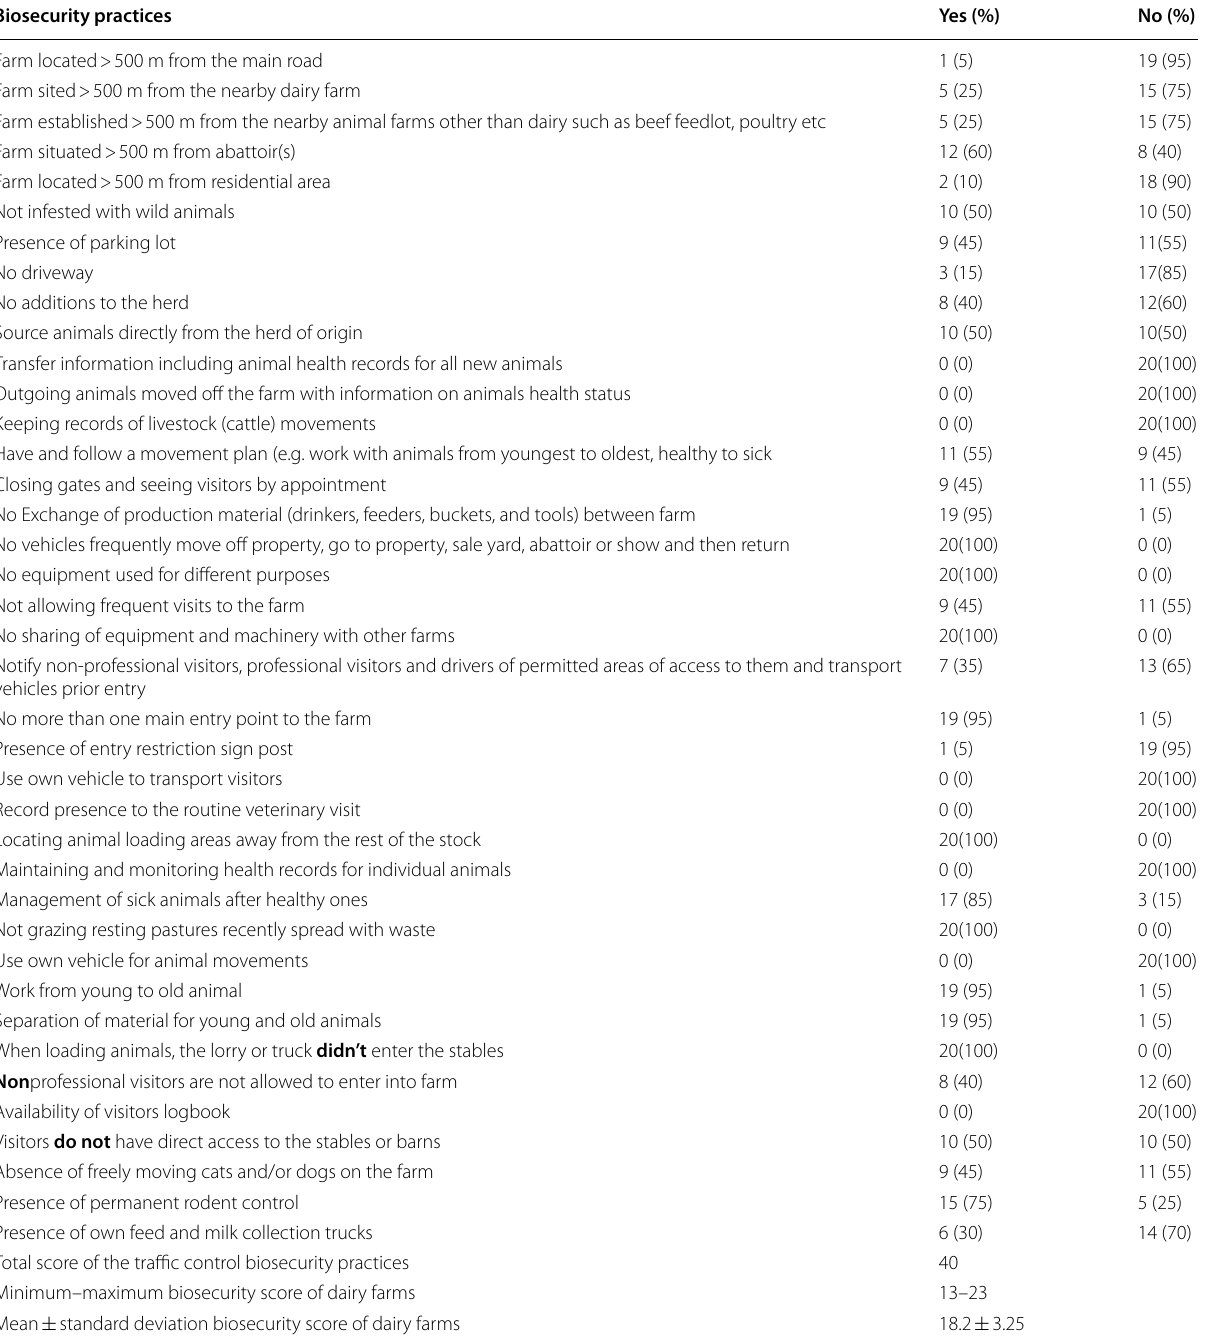
Table 4 Percentage of biosecurity practices of the traffic control component Biosecurity